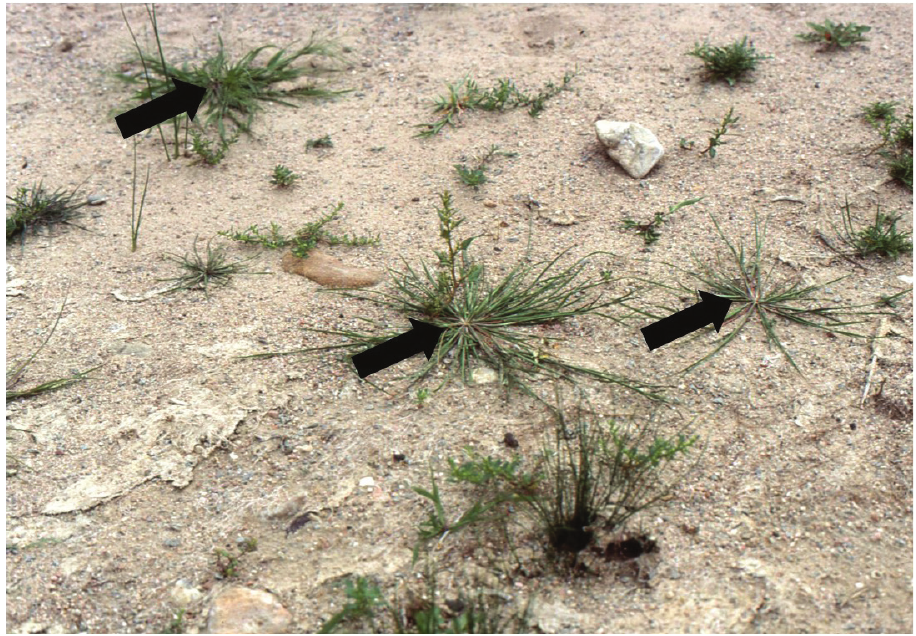
Figure 6 Prostrate growth form (arrows) of a high altitude (ca. 1425 m) population of Diplachne fusca subsp. fascicularis along margins of water impoundment (Platte Co., Wyoming; Snow